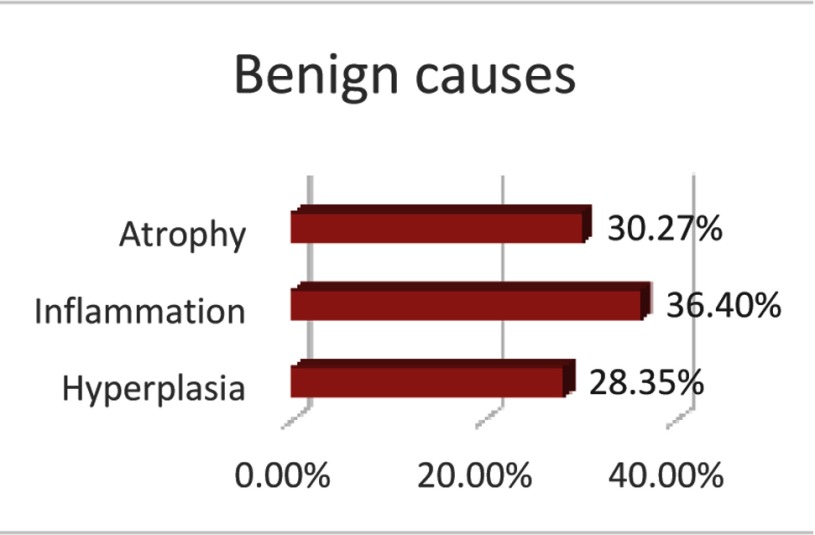
Benign causes of diffusion restriction.